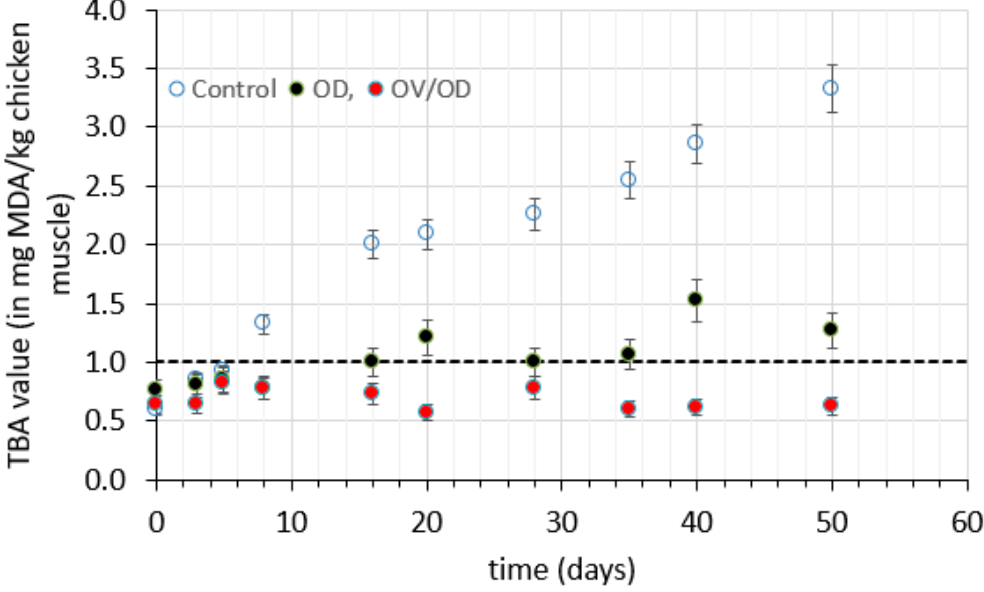
Figure 5. Lipid oxidation of chicken fillets (expressed as concentration of malondialdehyde, mg MDA/kg of chicken muscle) during storage at 4 °C.